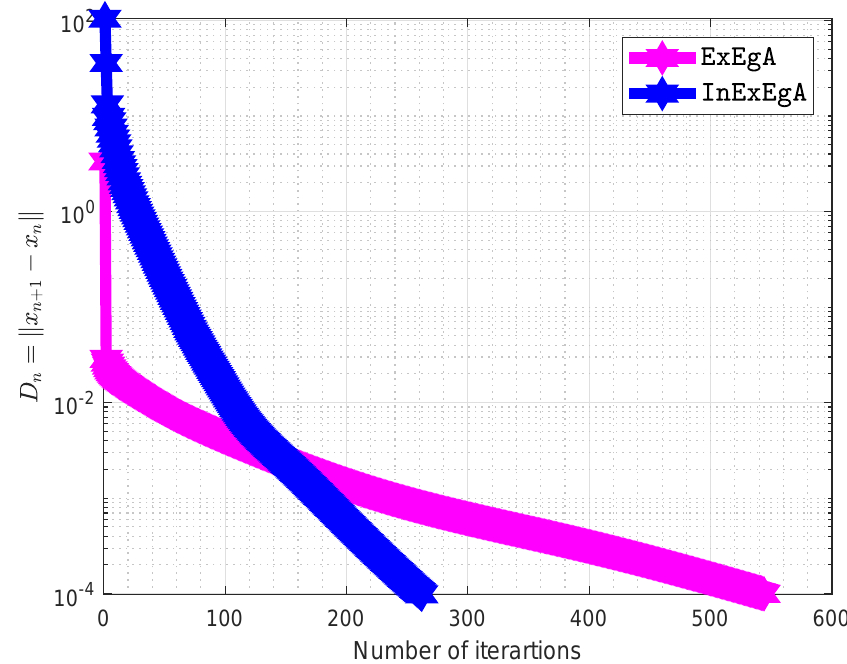
Figure 9. Algorithm 1 comparison with Algorithm 1 in [16] when m = 10.